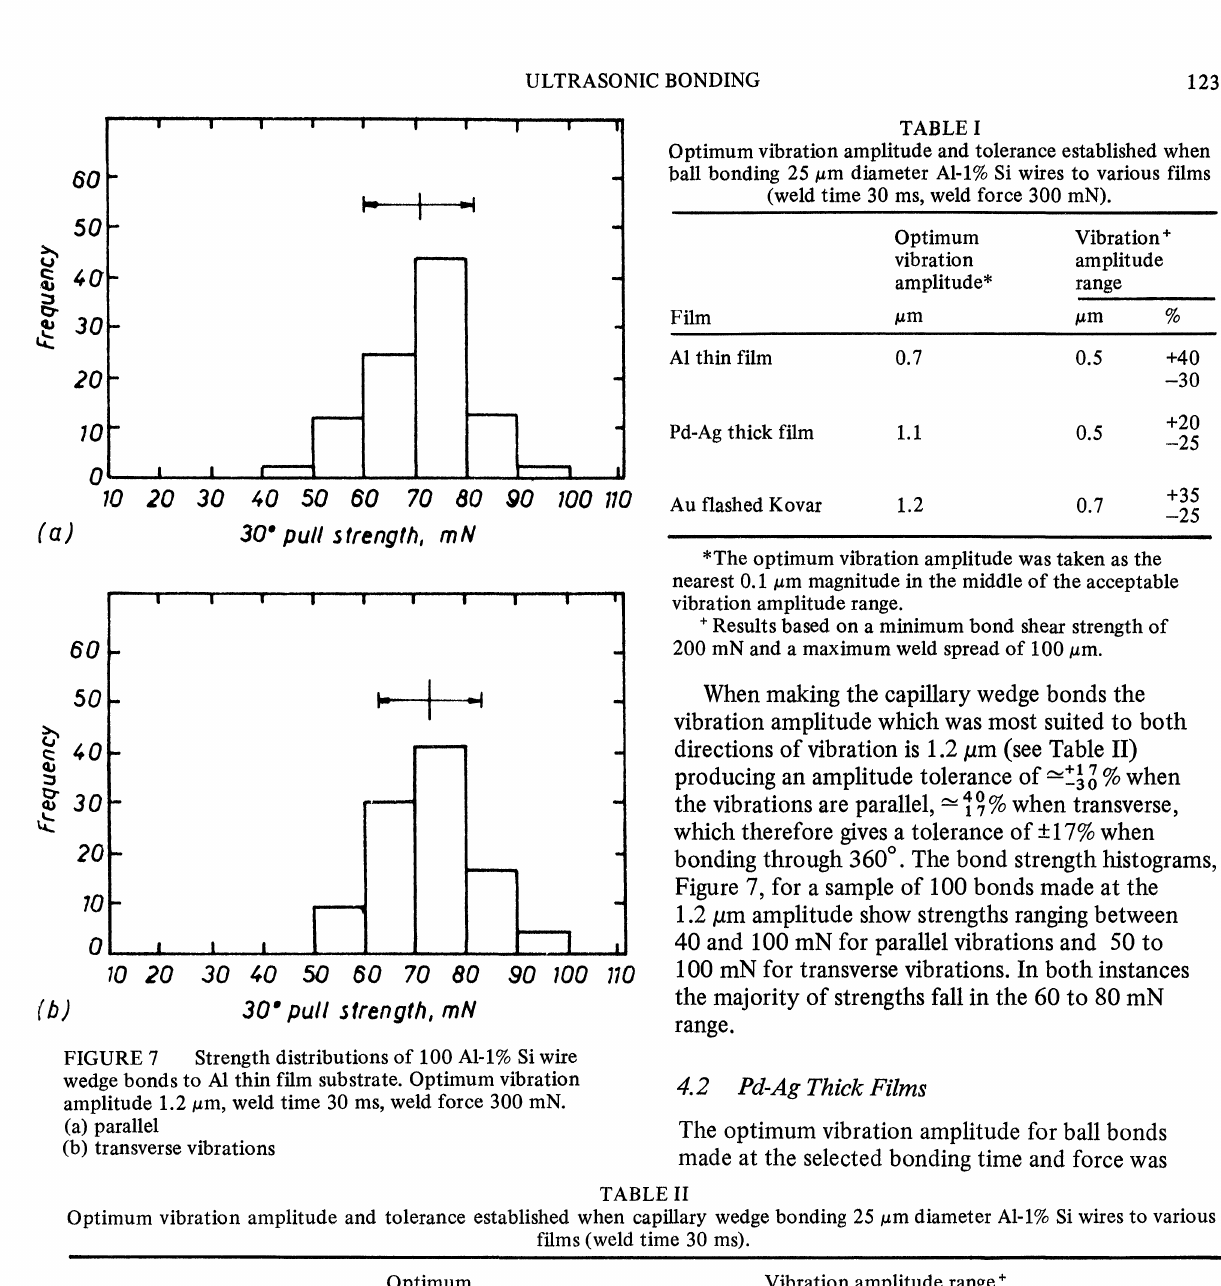
FIGURE 7 Strength distributions of 100 A1-1% Si wire wedge bonds to A1 thin film substrate. Optimum vibration amplitude 1.2 tzm, weld time 30 ms, weld force 300 mN. (a) parallel (b) transverse vibrations